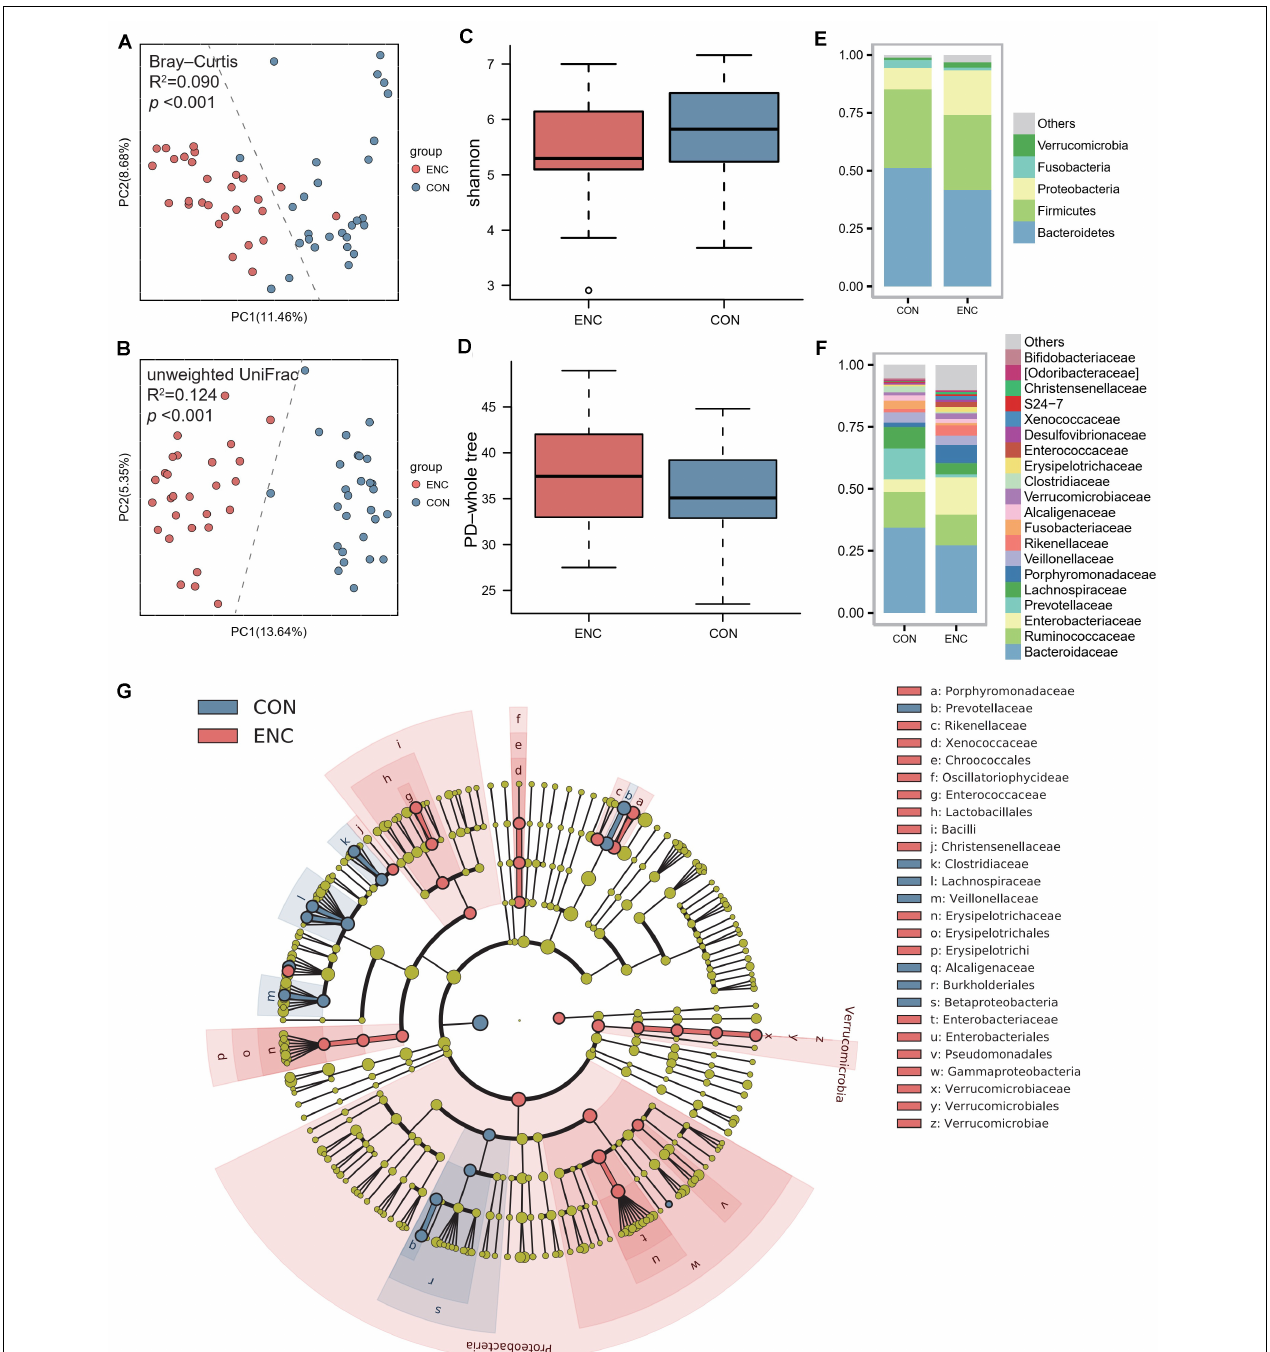
FIGURE 1 | The gut microbiota composition of encephalitis patients was significantly different from that of healthy subjects. (A,B) The β -diversity in the ENC and CON groups was calculated by the Bray-Curtis distance (A) and unweighted UniFrac distance (B) and is shown in the PCoA plot (Adonis test, Bray-Curtis distance, R 2 = 0.090, p < 0.001; unweighted UniFrac distance, R 2 = 0.124, p < 0.001). Each point represents the composition of the intestinal microbiota of one participant. (C,D) The α -diversity of the microbiota, presented as the Shannon index (C) and PD-whole tree index (D) , was calculated from samples from encephalitis patients and healthy subjects (Mann-Whitney U test, Shannon index, p = 0.098; PD-whole tree index, p = 0.350). The boxplots display the 95% CIs, and the points lying outside the whiskers are referred to as outliers. (E,F) Average relative abundances of the predominant bacterial taxa at the phylum (E) and family (F) levels in the ENC and CON groups. (G) Cladogram based on LEfSe results of the CON and ENC groups. The red points represent the increased taxa in ENC group, while the blue points represent the increased taxa in CON group. ENC, patients with encephalitis; CON, healthy subjects serving as controls.